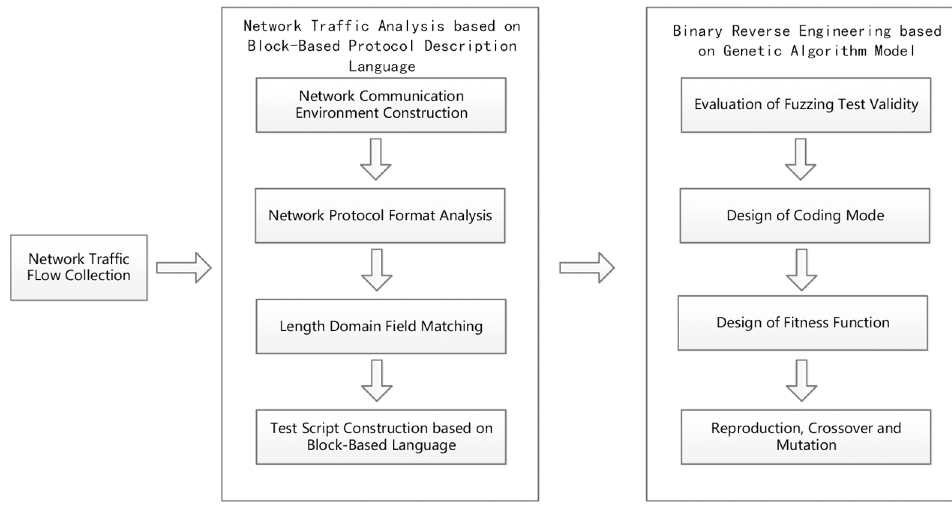
Fig 1. Framework of the proposed